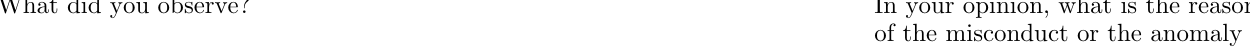
Table 3. Problems submitted to the RIQ-box. What did you observe?